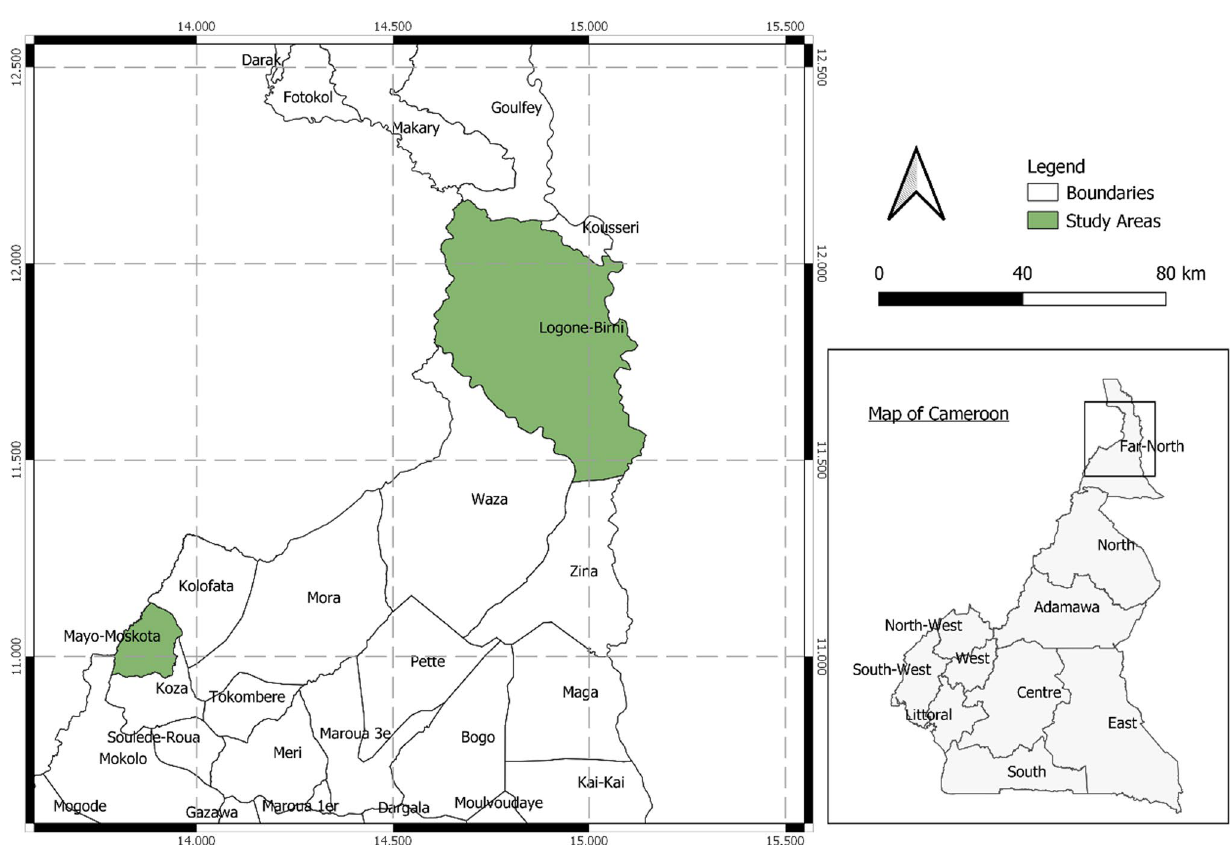
Fig. 1 Geographical Location of the Study Areas. (Source: Forestry Atlas